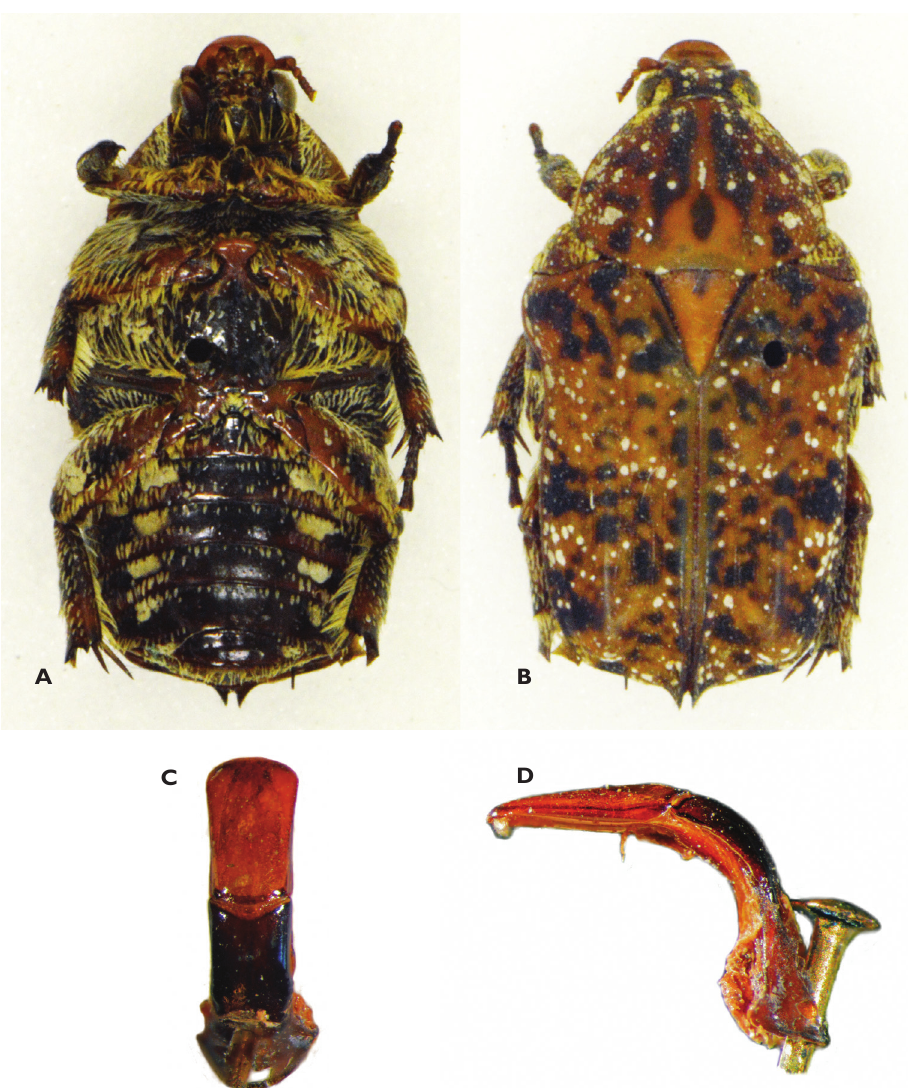
Figure 11. Atrichelaphinis ( Eugeaphinis ) rhodesiana (Péringuey, 1907), holotype (ISAM). A Dorsal view B ventral view C parameres in dorsal view D parameres in lateral